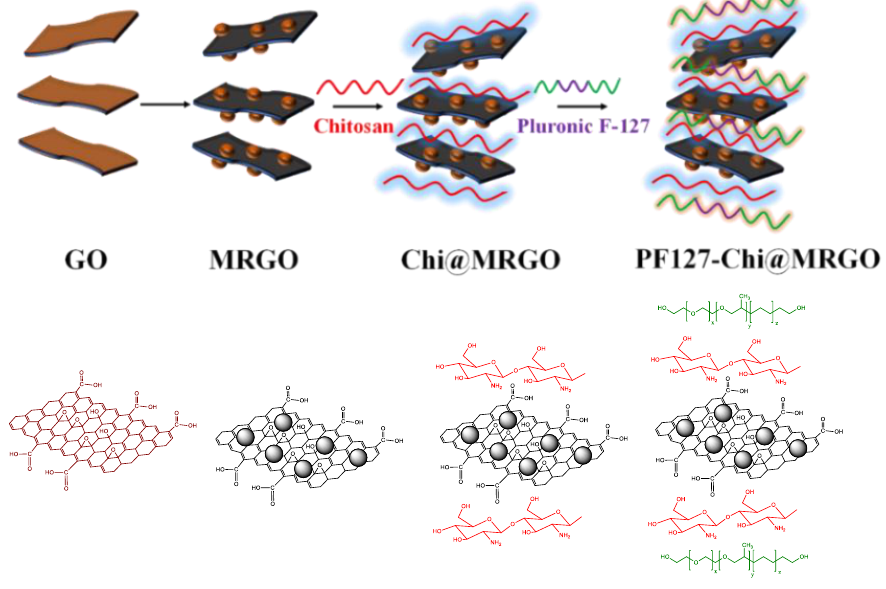
Figure 1. Schematic diagram of nanocomposites formation.